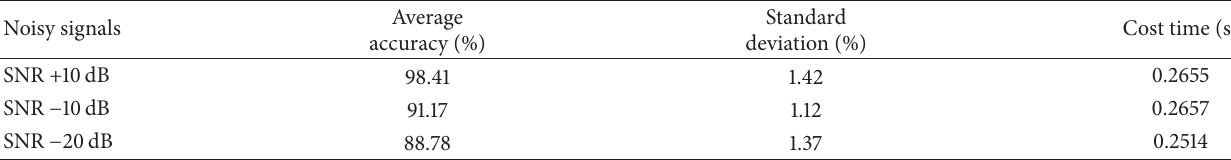
Table 7: Classification results of the proposed methods for the noisy signals.